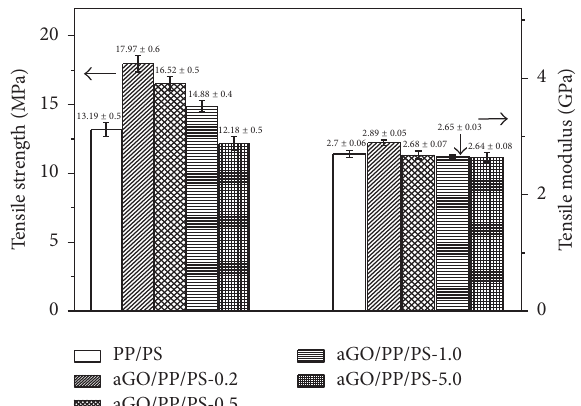
Figure 5: Tensile strength and tensile modulus of uncompatibilized PP/PS and aGO/PP/PS blends with various aGO loadings: aGO/PP/PS- 0.2, aGO/PP/PS-0.5, aGO/PP/PS-1.0, and aGO/PP/PS-5.0.